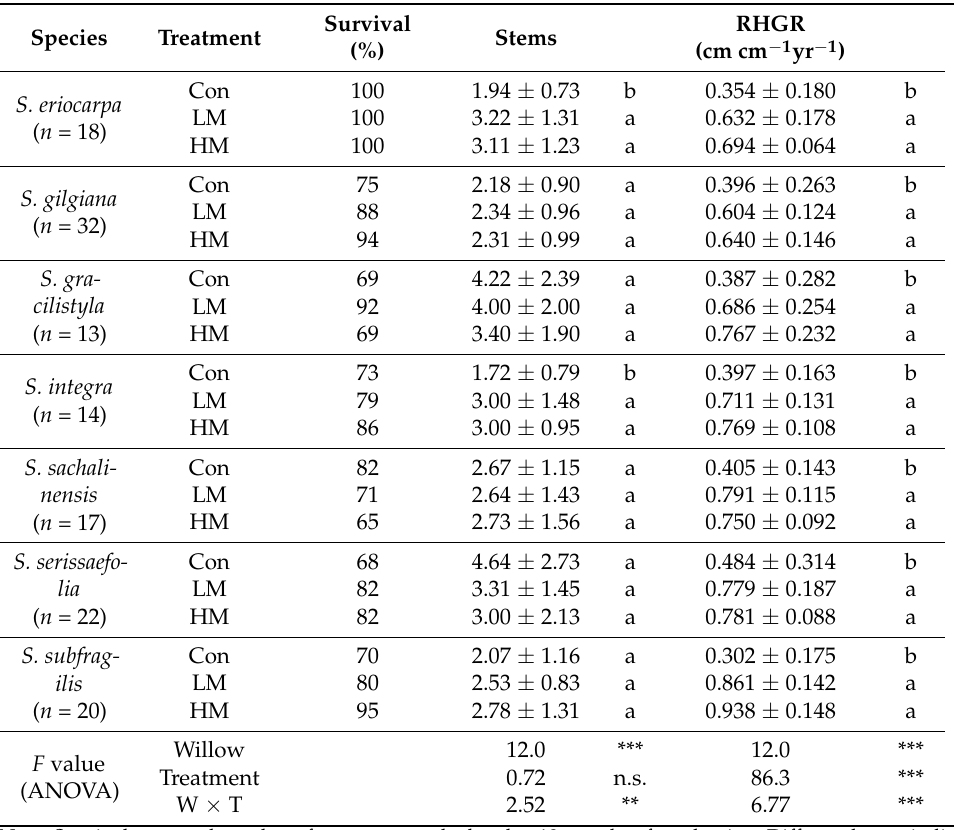
Table 3. Survival rates of individuals, number of stems per individual and RHGR for the individual of seven willows grown under three treatments (mean ± SD except for survival). Asterisks indicate significant differences among seven willows, three treatments, and their interaction (W × T) calculated by ANOVA. ** = p < 0.01 and *** = p < 0.001.